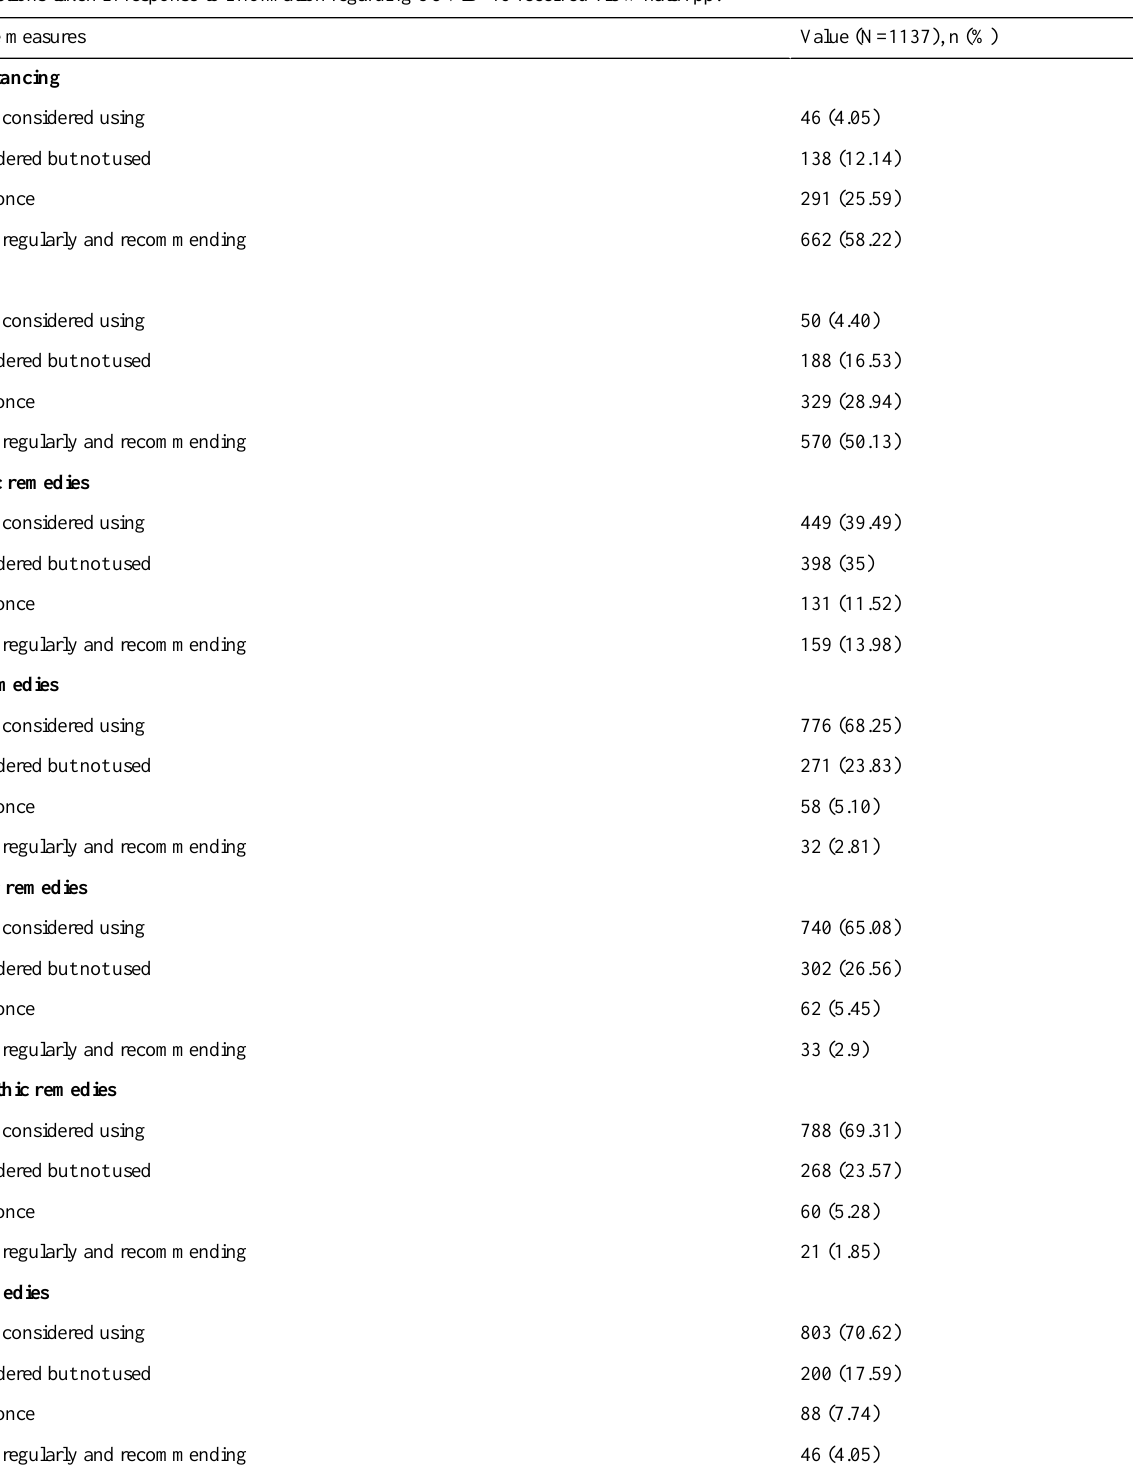
Table 4. Actions taken in response to information regarding COVID-19 received vis